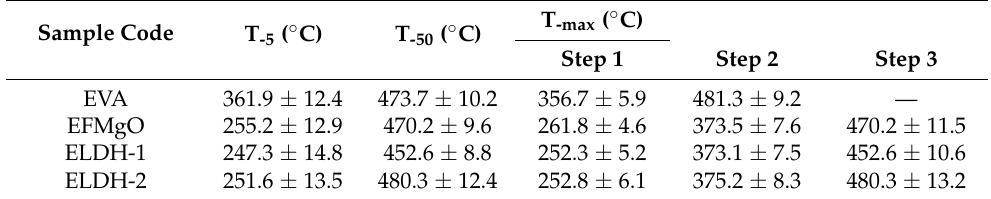
Table 4. The TG results of the EVA, EFMgO, ELDH-1, and ELDH-2 composites under nitrogen condition.